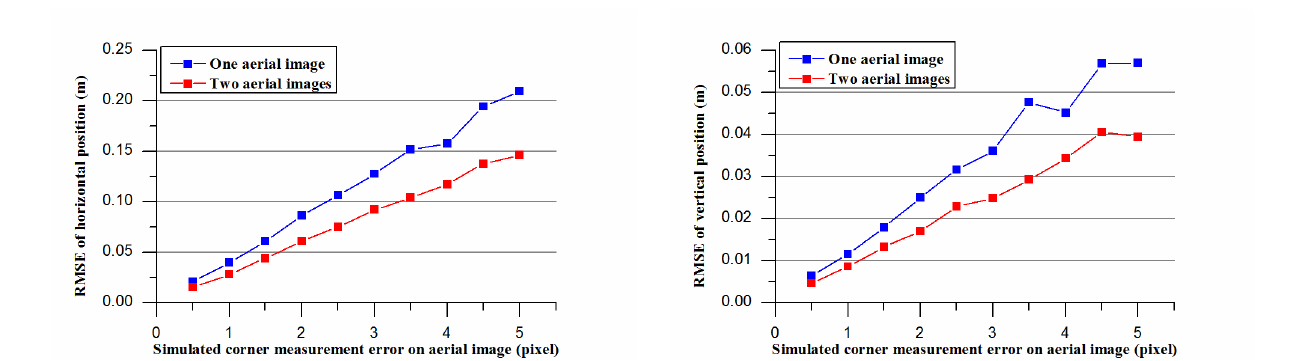
Figure 7. Horizontal error ( Left ) and vertical error ( Right ) of one image and two